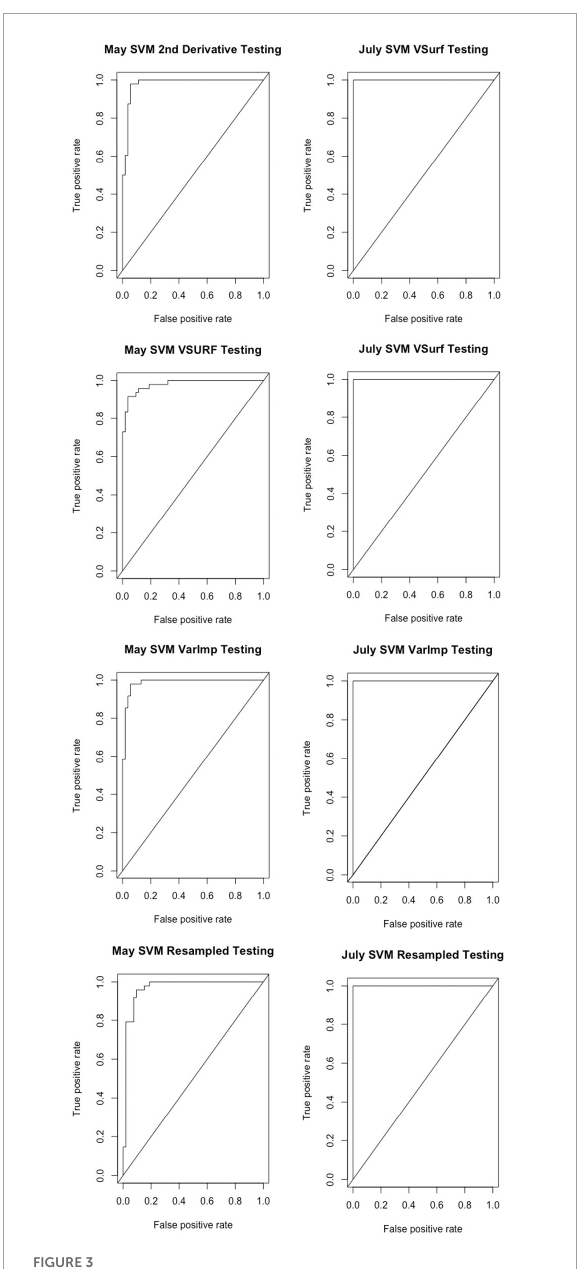
FIGURE3 Receiver operating characteristic (ROC) curves derived from the testing of the support vector machine (SVM) models, showing the classification accuracy of spectra from pre-symptomatic (excluding the Kiwanis site) and distal-naïve samples for both the May (left) and July (right) datasets. The diagonal line represents perfect chance